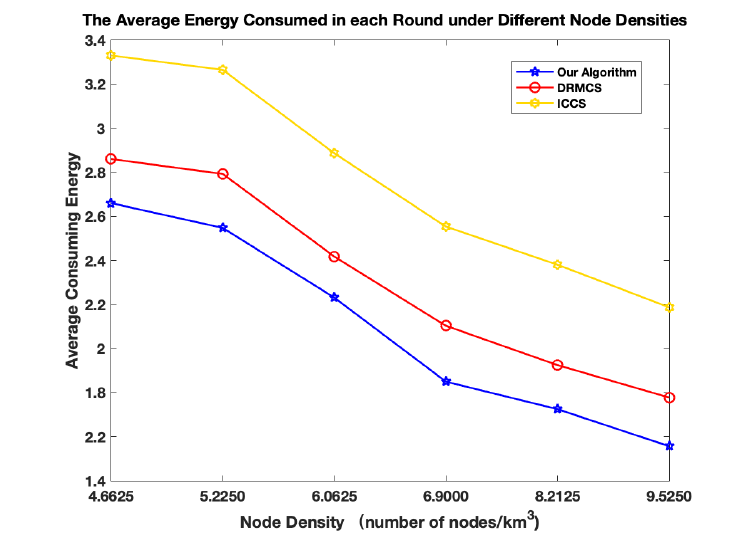
Figure 10. The comparison results in terms of average energy consumption with different node densities.